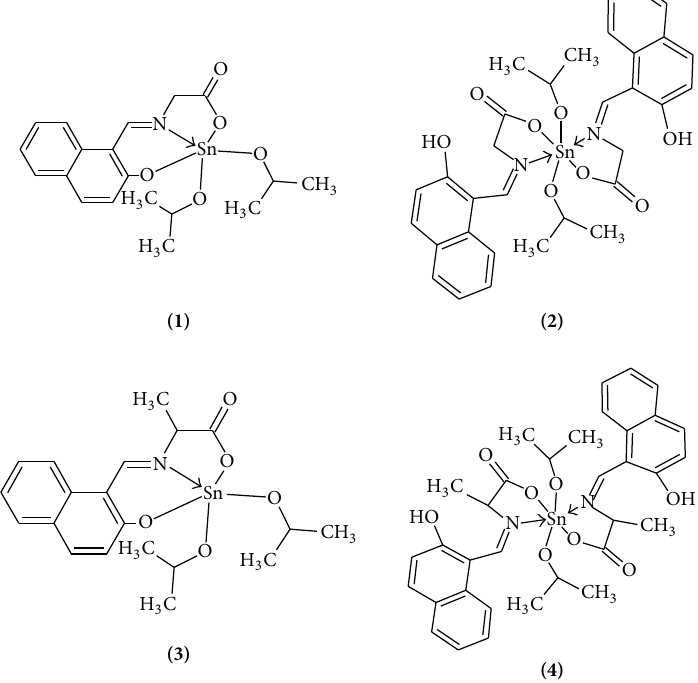
F 2: Structure of tin (IV) complexes.